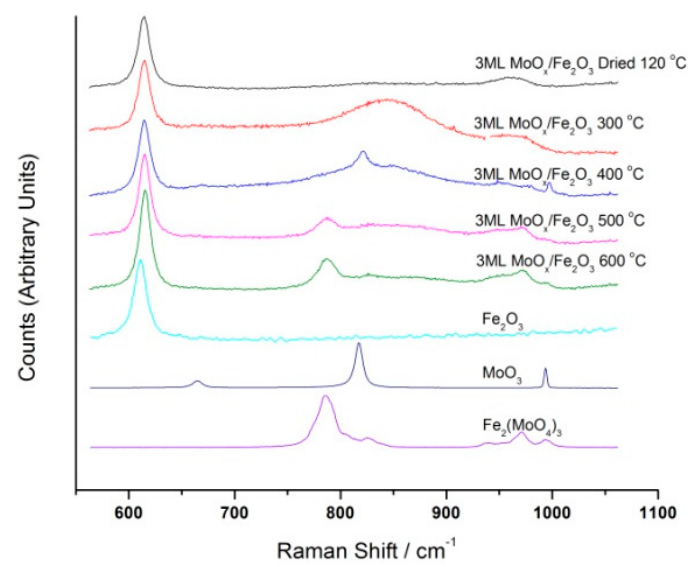
Figure 9. Raman spectra of 3ML MoO x /Fe 2 O 3 for dried 120 °C, 300, 400, 500, 600 °C and their reference spectra Fe 2 O 3 , MoO 3 and Fe 2 (MoO 4 ) 3 . Image adapted from C. Brookes et al. ACS Catal. , 2014, 4 (1), pp. 243–250 [16].